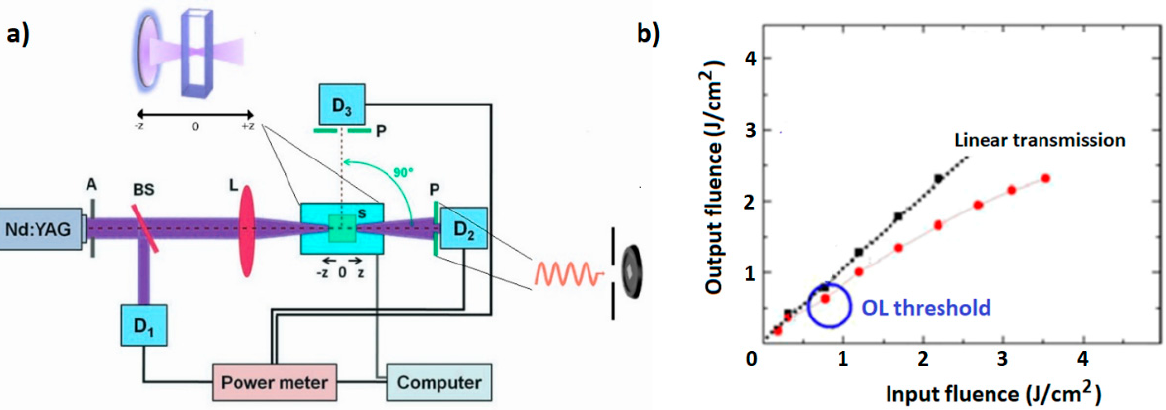
Figure 1. (a) Schematics of the z-scan setup. (b) Nonlinear transmittance values as a function the input fluence to determine the OL threshold.